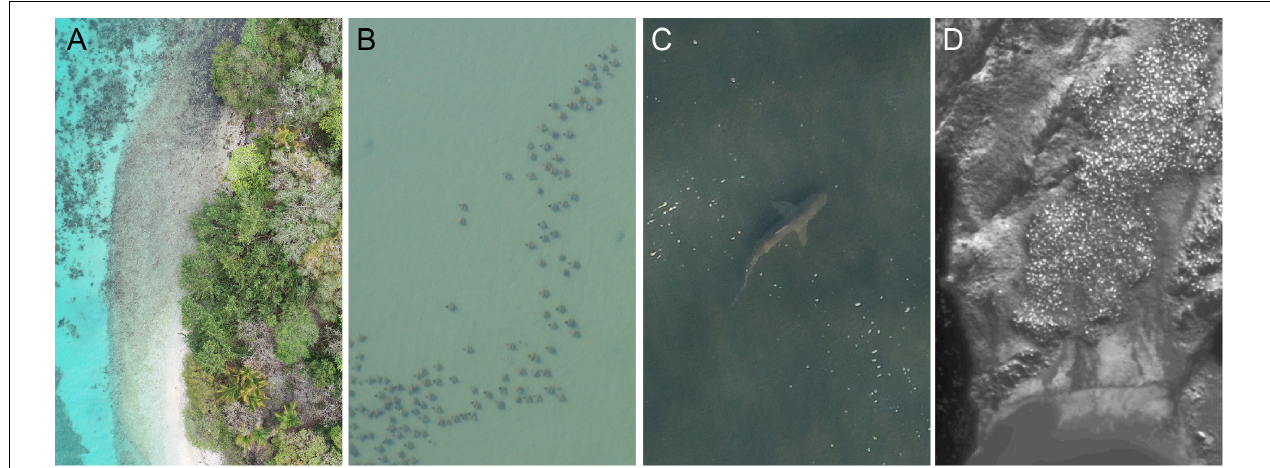
FIGURE 4 | Examples of UAS data products capturing the presence and locations of non-native coconut palms among mangroves in Belize (A) , the migration of thousands of cownose rays in a North Carolina estuary (B) , shark behavior (C) , and the thermal signatures (white dots) of a penguin colony (D) . All images obtained by Duke University Marine Robotics and Remote Sensing Lab, collected under